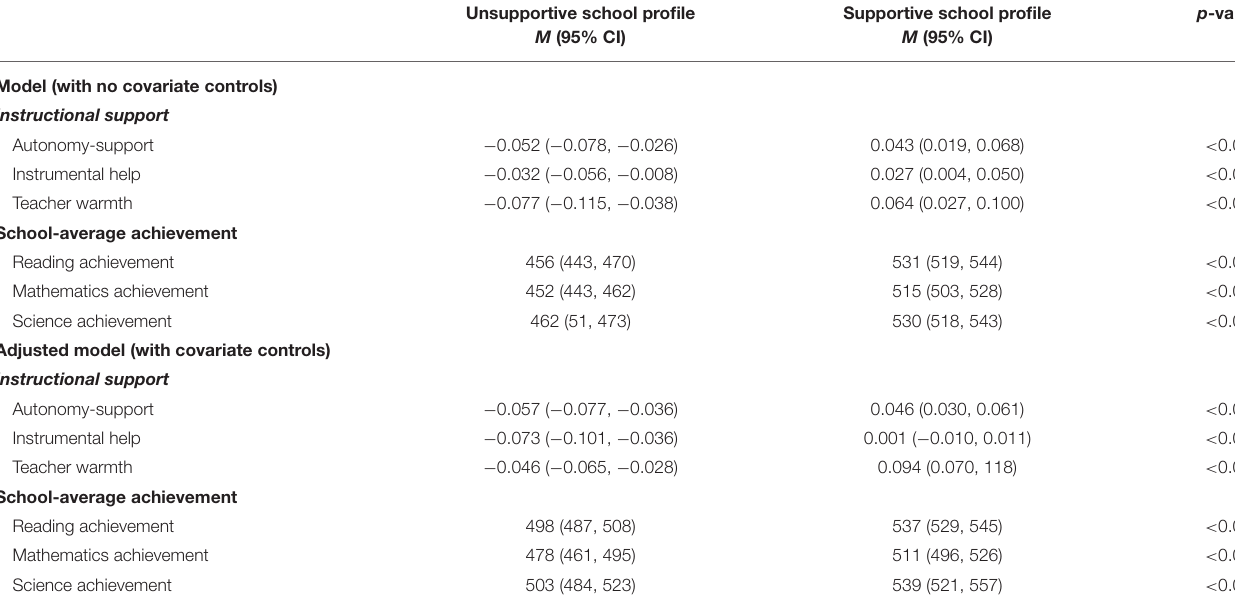
TABLE 8 | Means of student-reported outcomes related to instructional practice and achievement (Phase